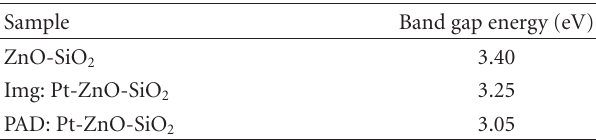
Figure 5: N 2 sorption isotherms of ZnO-SiO 2 , PAD-Pt/ZnO-SiO 2 , and Img-Pt/ZnO-SiO 2 . Table 2: The calculated band gap energy of ZnO-SiO 2 , Img: Pt- ZnO-SiO 2 , and PAD: Pt-ZnO-SiO 2 .